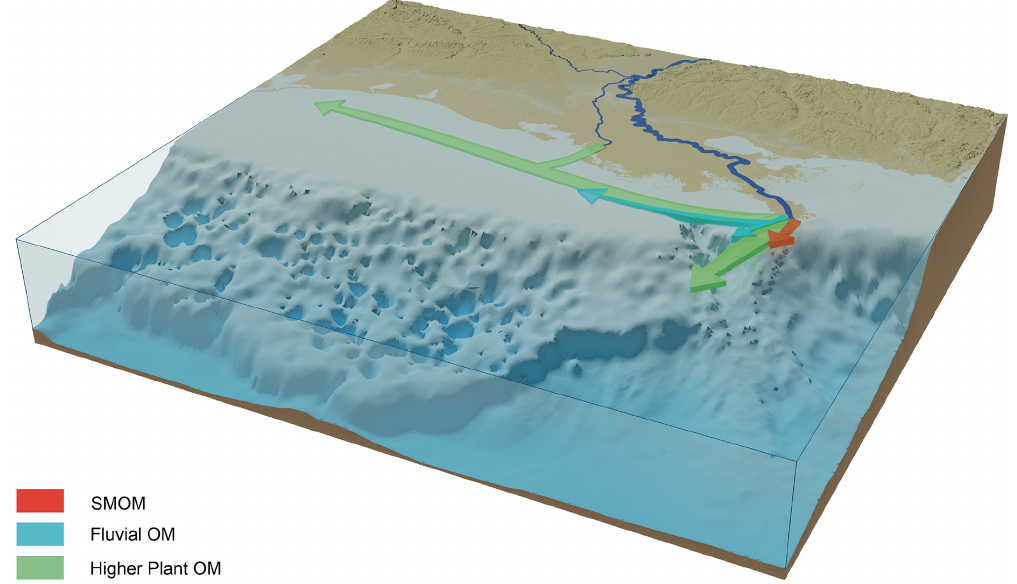
Figure 11. Schematic overview of the dispersal of SMOM, fluvial, and higher plant-derived OM in the northern GoM based on the lipid biomarker, pollen, and dinocyst distributions from this